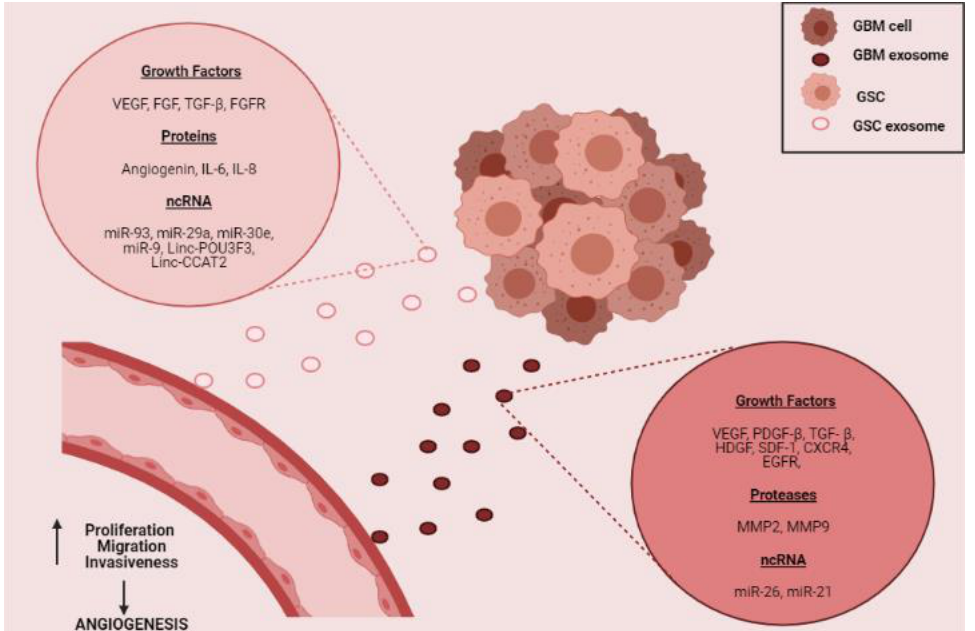
Figure 4. Schematic of possible participation of GBM cell-derived exosomes in promoting angiogenesis in the tumor niche. The figure depicts the possible content of exosomes derived from GSC and/or those derived from GBM tumor cells (growth factors, proteins, proteases, and ncRNAs) [5,6,8,9,89–91]. Besides, the uptake of these microvesicles by EC in the tumor vasculature, may promote the increase in the formation of new blood vessels through the promotion of cell proliferation, migration, and invasiveness